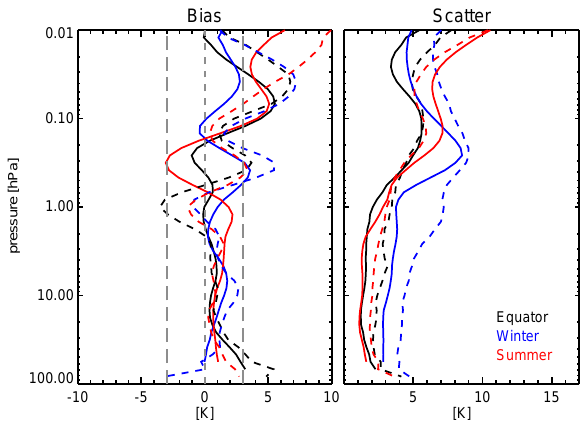
Fig. 18. Mean temperature biases (left) and scatter (right) between the MIPAS linear retrieval, MORSE (solid) and MLS (dashed). The gray dashed line shows a 3 K difference. The number of profiles compared in each bin for the MLS comparison were 40, 2918 and 3159 for the equatorial, winter and summer case respectively.